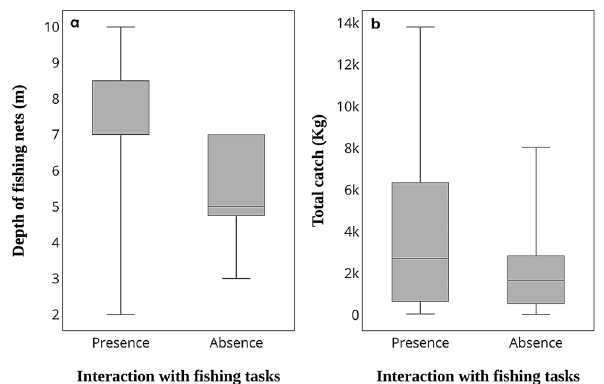
Figure 3. Relationship between the occurrence of interactions with the fishing tasks and ( a ) the depth of the fishing nets, and ( b ) the total salmon catch.